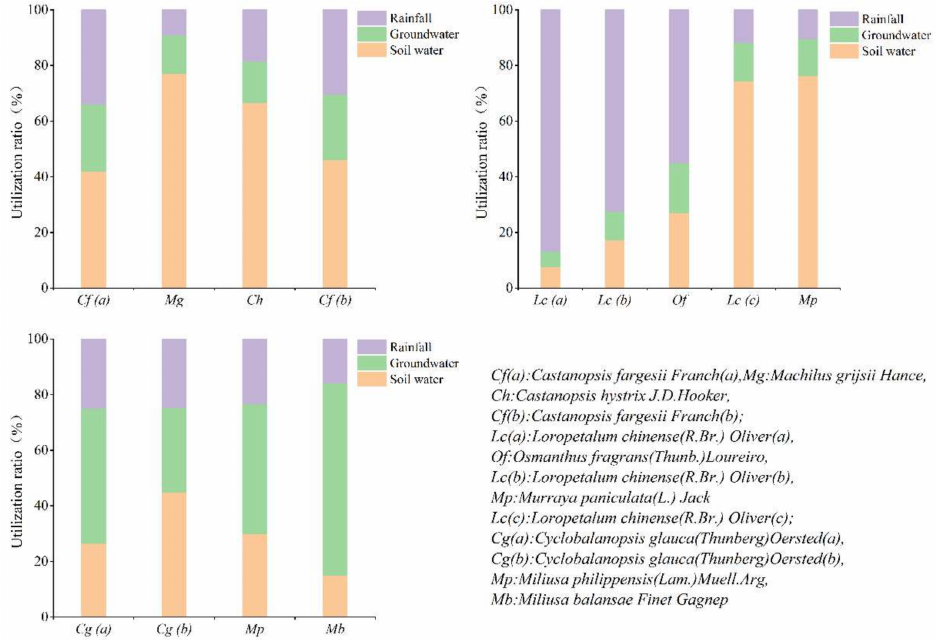
Figure 7. Stem water source proportion results from the IsoSource